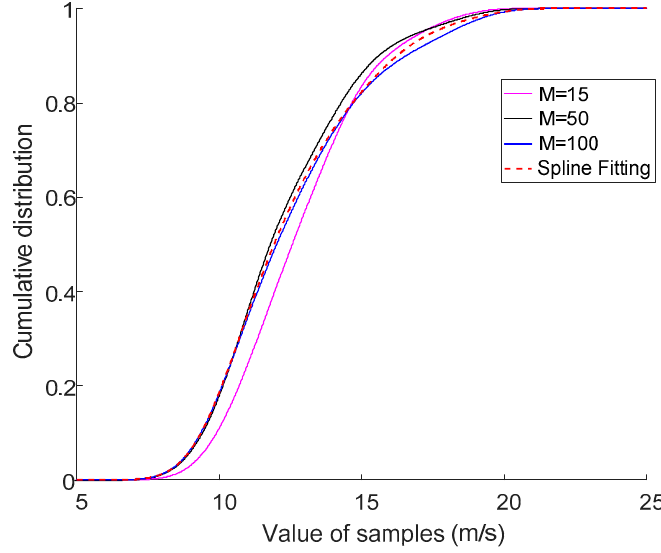
Figure 2. Comparison of the cumulative distribution curves.